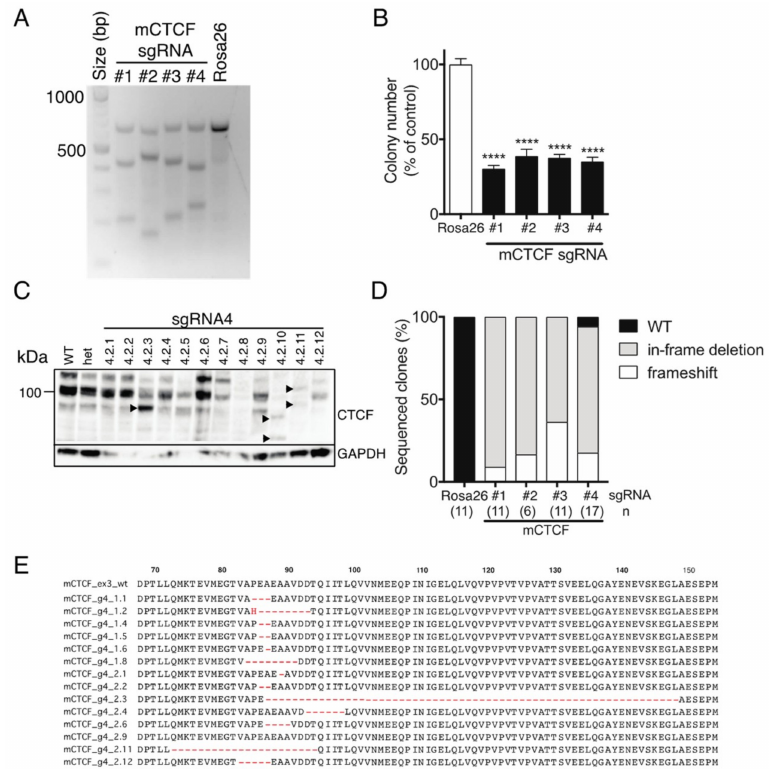
Figure 5. CRISPR/Cas9-directed editing of Ctcf in hemizygous MEFs. ( A ) Ctcf +/pgkneo MEFs transduced with Cas9 and sgRNA-containing lentivectors (mouse Ctcf exon 3 sgRNAs #1, #2, #3, and #4; Rosa26 sgRNA) were FACS-enriched and subjected to T7EI digestion of Ctcf exon 3 amplicons amplified from isolated gDNA. Approximate expected sizes (in bp) for digested products #1 (427, 214), #2 (476, 165), #3 (428, 213), and #4 (399, 242). Clonogenicity assay ( B ); Western blot analysis of individual clones (from sgRNA#4, arrowheads indicate lower molecular weight Ctcf variants) ( C ); and molecular genetic analysis of individual clones; n=number of clones sequenced (in brackets) ( D ). ( E ) Examples of frequently occurring in-frame deletions in Ctcf +/pgkneo MEFs (from sgRNA#4). Quantitative data represent the mean ± SEM for three experiments each performed in triplicate. Statistical analysis was performed using Mann-Whitney U-test (ns = not significant, **** p <